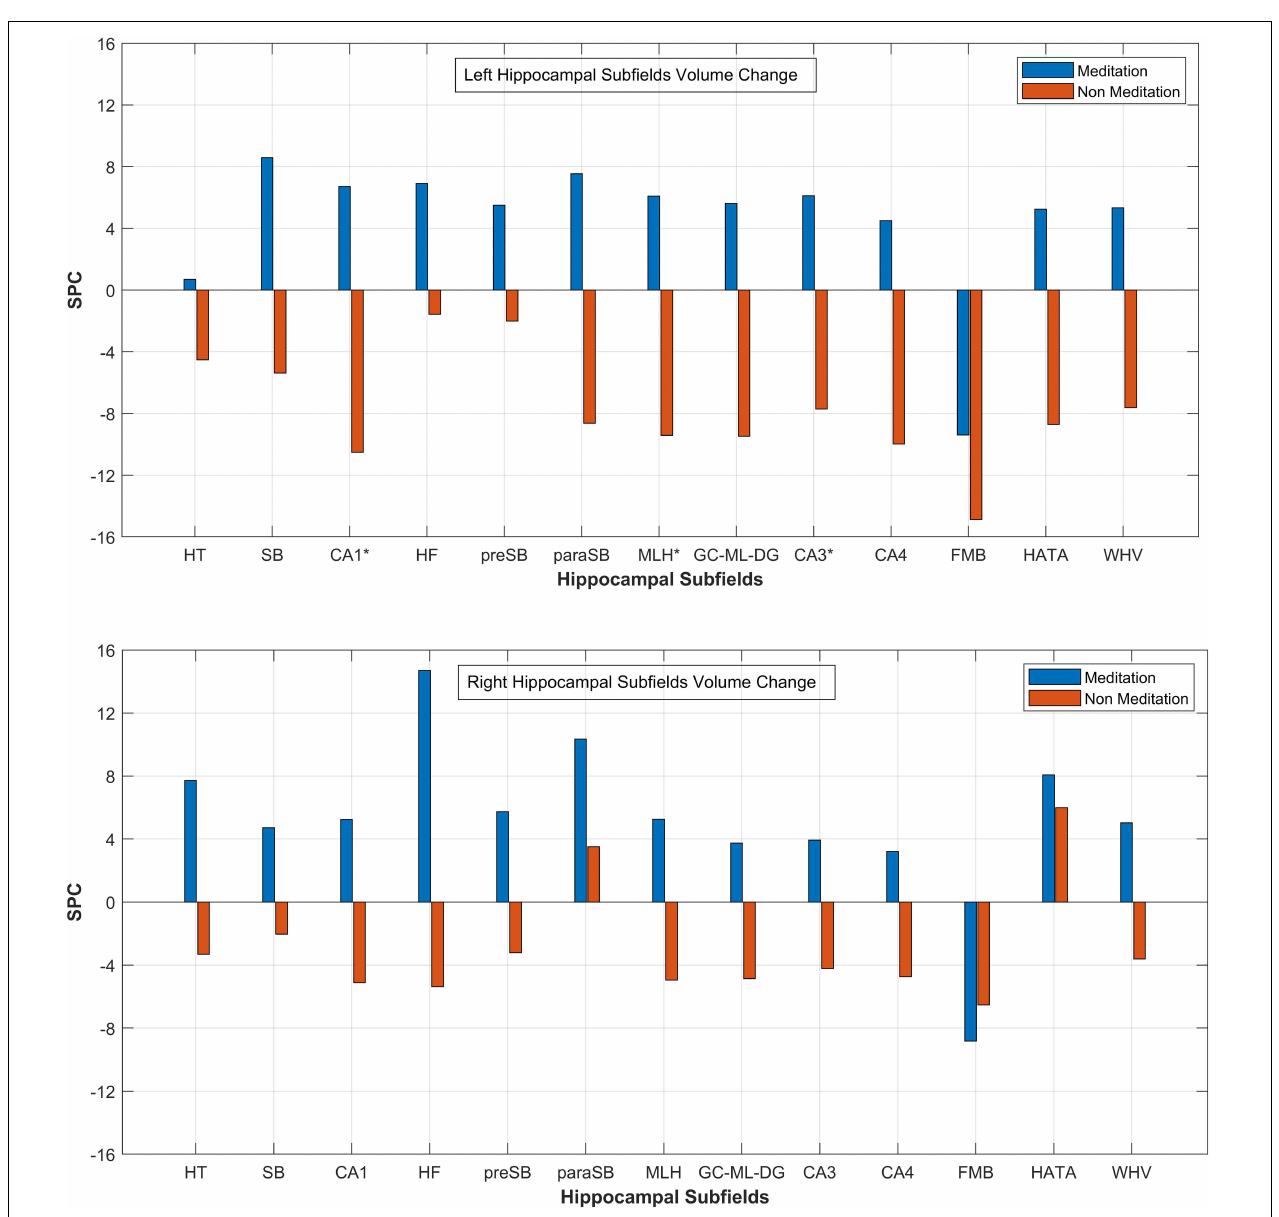
FIGURE 5 | Mean SPC values for volume of each Left and Right Hippocampal Subfields respectively for the mediation and the non-meditation groups. HT, hippocampal tail; SB, subiculum; CA1, HF, hippocampal fissure; preSB, presubiculum; paraSB, parasubiculum; MLH, molecular layer HP; GC-ML-DG, [Granule Cell (GC) and Molecular Layer (ML) of the Dentate Gyrus (DG)]; FMB, fimbria; HATA (hippocampus-amygdala-transition-area); WHV, Whole Hippocampal Volume. *Corresponds to significant changes in the subfield’s